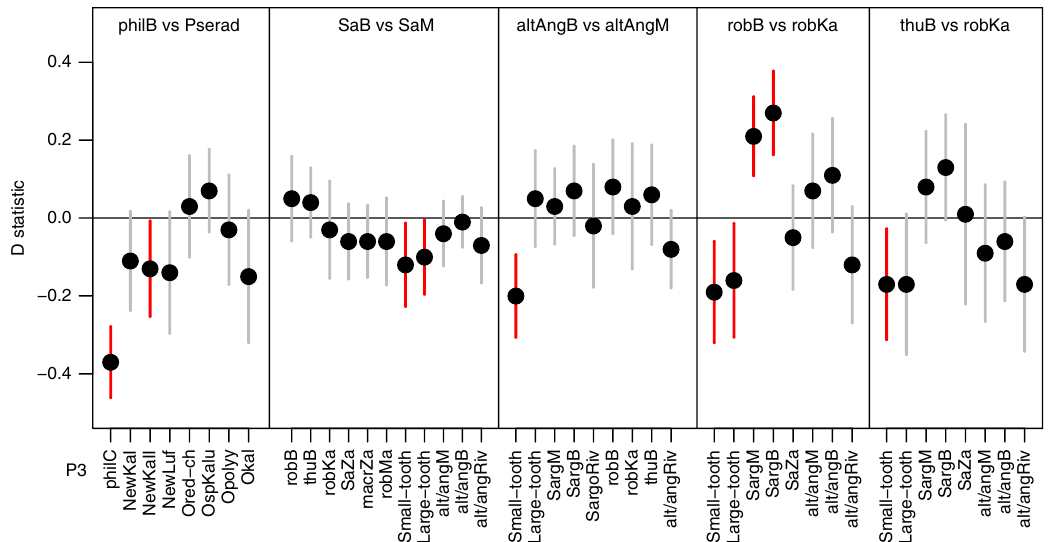
Fig. 4 Lake Bangweulu taxa show no signatures of hybridization. Comparisons of Bangweulu taxa (as P1) with their closest relatives (sister taxon in Lake Mweru as P2) reveals no evidence for excess allele sharing between any Bangweulu taxon with any other taxon (P3) in our dataset, which would lead to positive D statistics. The only exception is Se. robustus , which shows excess allele sharing with Sargochromis both of Lake Mweru and of Lake Bangweulu. Given that the two Sargochromis lake clades do not differ in allele sharing with Se. robustus of Bangweulu (see fi rst test of ‘ SaB vs SaM ’ in this fi gure) and that slight excess allele sharing is also observed in the closely related Se. thumbergi of Lake Bangweulu, gene fl ow likely occurred from Se. robustus Bangweulu into the common ancestor of both Sargochromis lake clades. Therefore, the onxly signature of hybridization involving a Bangweulu taxon is shared by both Bangweulu and Mweru taxa and may re fl ect hybridization in the distant past. Hence, there is no additional event of hybridization in Lake Bangweulu, whereas there is rampant evidence for hybridization among multiple different Lake Mweru taxa (see Fig. 3). Abbreviations and colour scheme follow those in Fig. 3. Exact values are given in Supplementary Data 10. The R script and the input fi le used to make this fi gure are provided at Zenodo